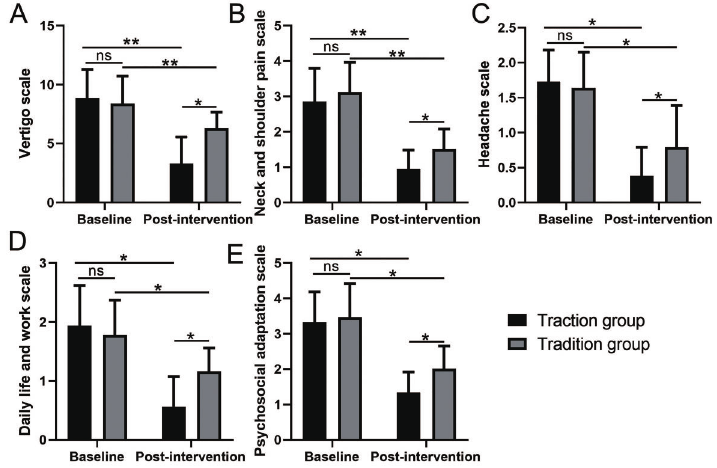
Figure 4. Effects of traction therapy on cervical vertigo symptoms and function ( A – E ) of patients with cervical vertigo due to atlantoaxial joint dislocation. Data are reported as means ± SD. *P o 0.05, **P o 0.01, paired t -test and unpaired t -test. ns: not signi fi